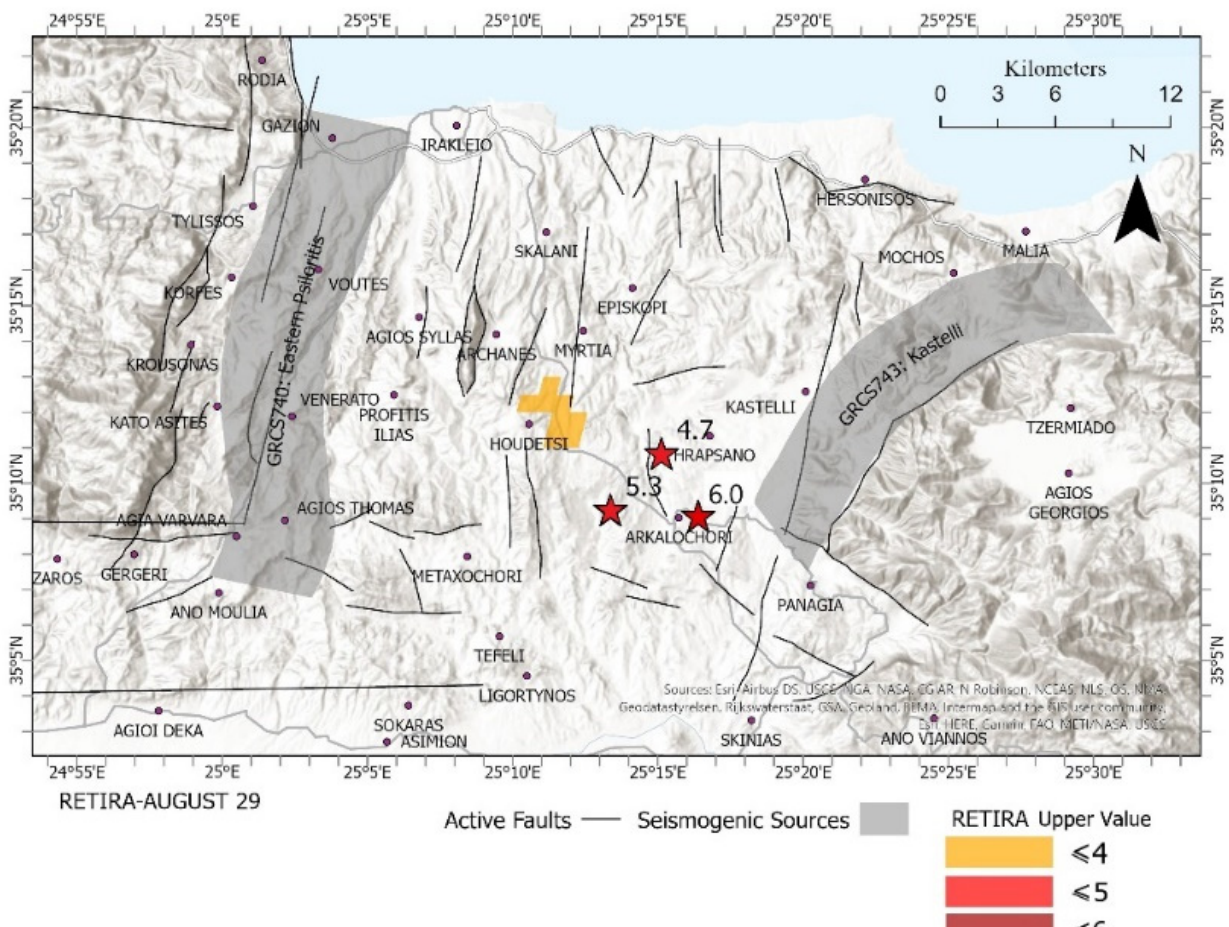
Figure 3. RETIRA thermal anomalies during August 2021 as observed on Central Crete are depicted with graduated colors depending on their value. The seismogenic source zones and the active faults are also indicated. The epicenters of the main event and of the two major aftershocks are shown with red stars.